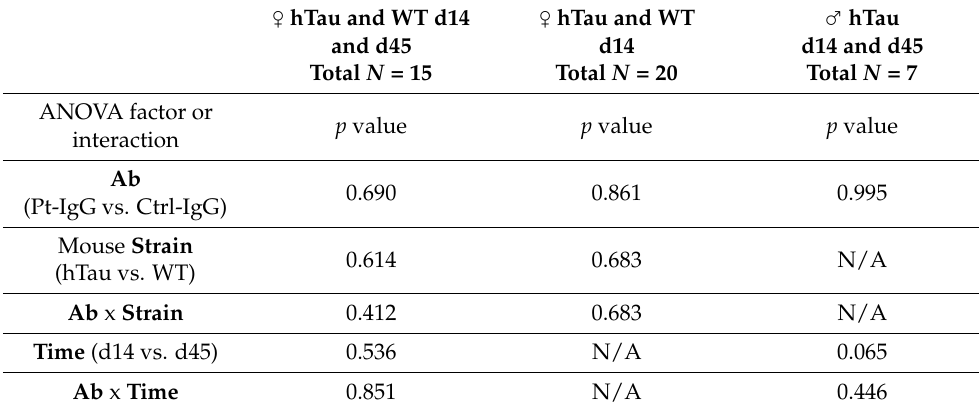
Table A4. Statistical analysis of sleep phenotype: time spent in REM